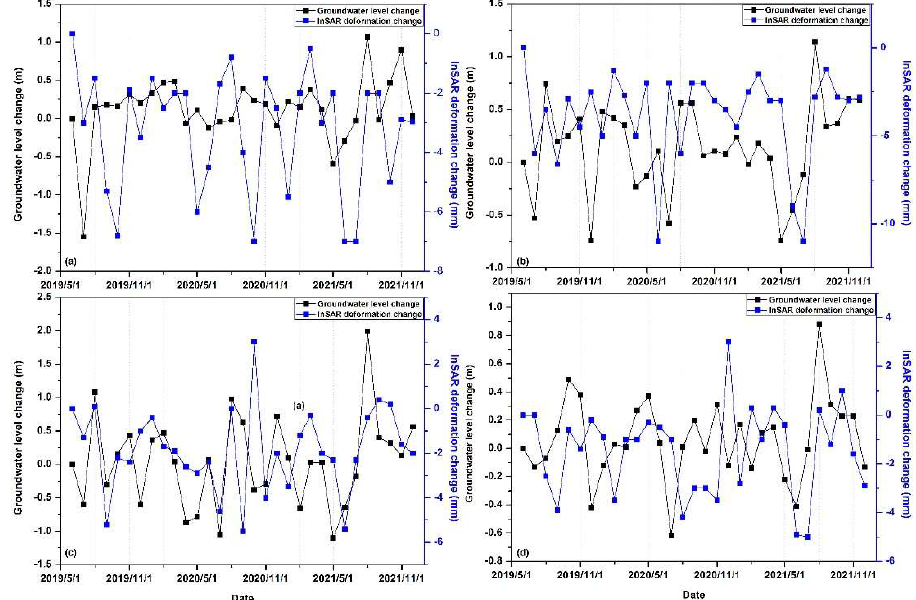
Figure 11. Time series of the monthly groundwater level change and InSAR-derived deformation change of the selected regions (( a ) A1, ( b ) A2, ( c ) A3 and ( d ) A4).